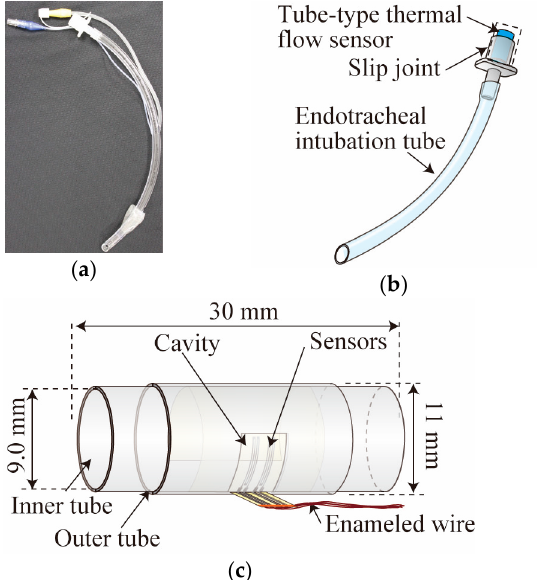
Figure 2. Adult-sized tracheal intubation tube device: ( a ) Actually used adult-sized tracheal intubation tube; ( b ) Flow sensor integration to adult-sized tracheal tube; ( c ) Tube-type thermal flow sensor for adult-sized tracheal intubation tube